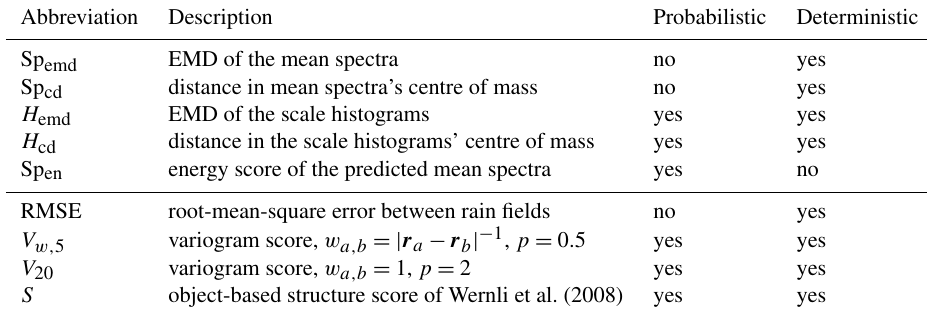
Table 1. Wavelet-based structure scores (top part) and established alternatives (bottom).